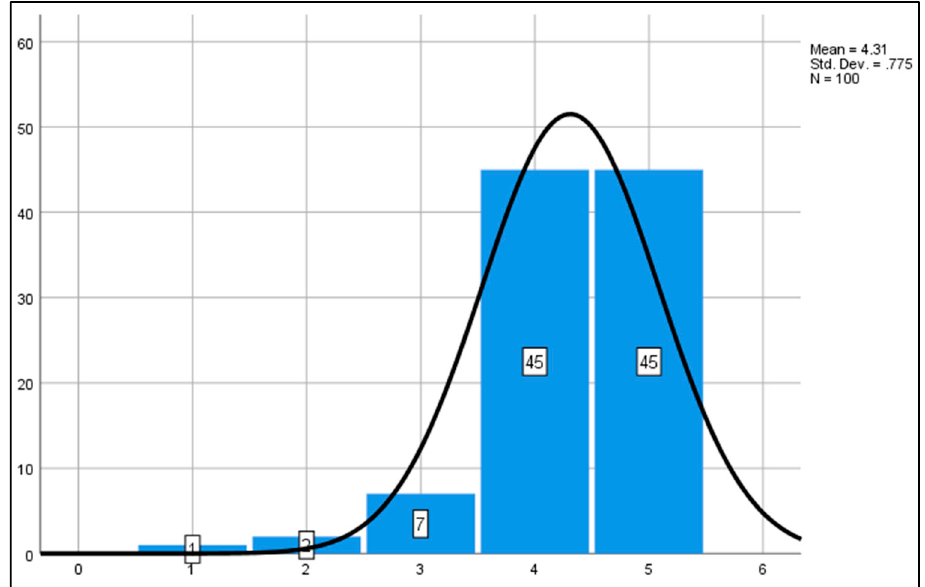
Figure 10 . Management support and Industry 4.0 readiness. Figure 10. Management support and Industry 4.0